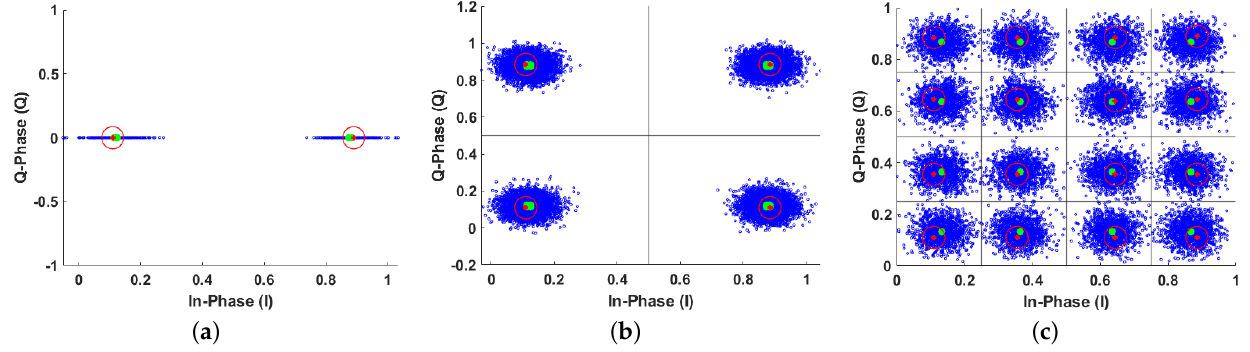
Figure 9. Constellation diagram for ( a ) PAM-2, ( b ) QAM-4 and ( c ) QAM-16 signals. Red is the reference, green is received signal without OSNR and blue is received signal with OSNR at 200 Gb/s (100 GHz).